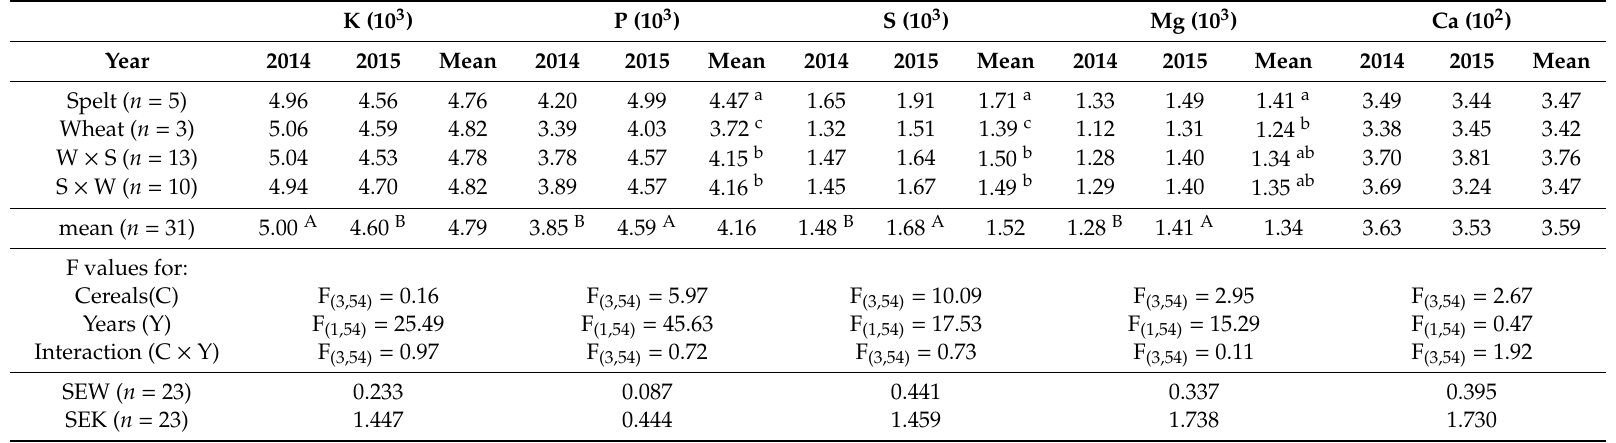
Table 4. Mean contents of potassium phosphorus, sulfur, magnesium and calcium (mg kg − 1 ) in the grains of hybrids between bread wheat and spelt in relation to their parental forms.